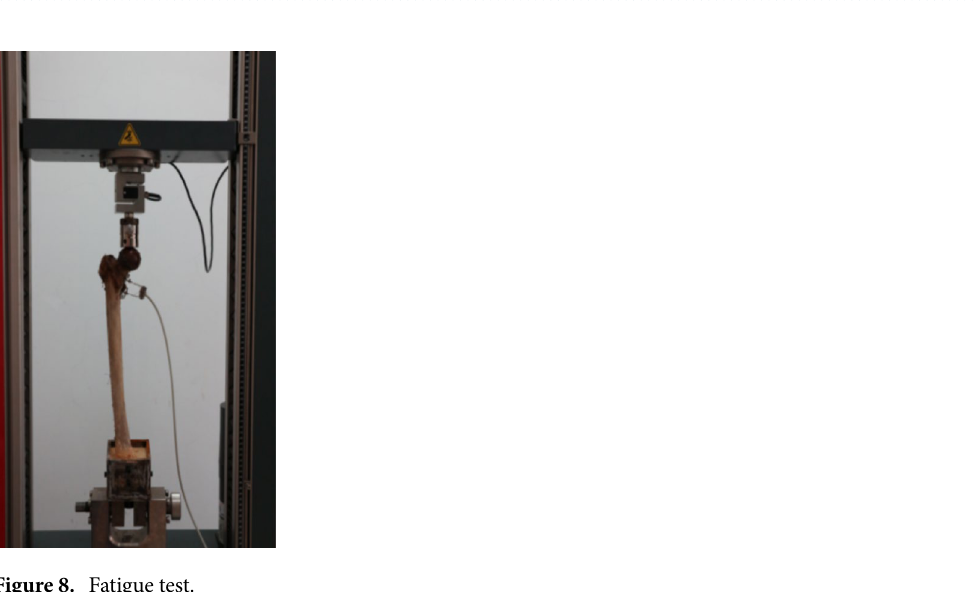
Figure 7. Torsion test.